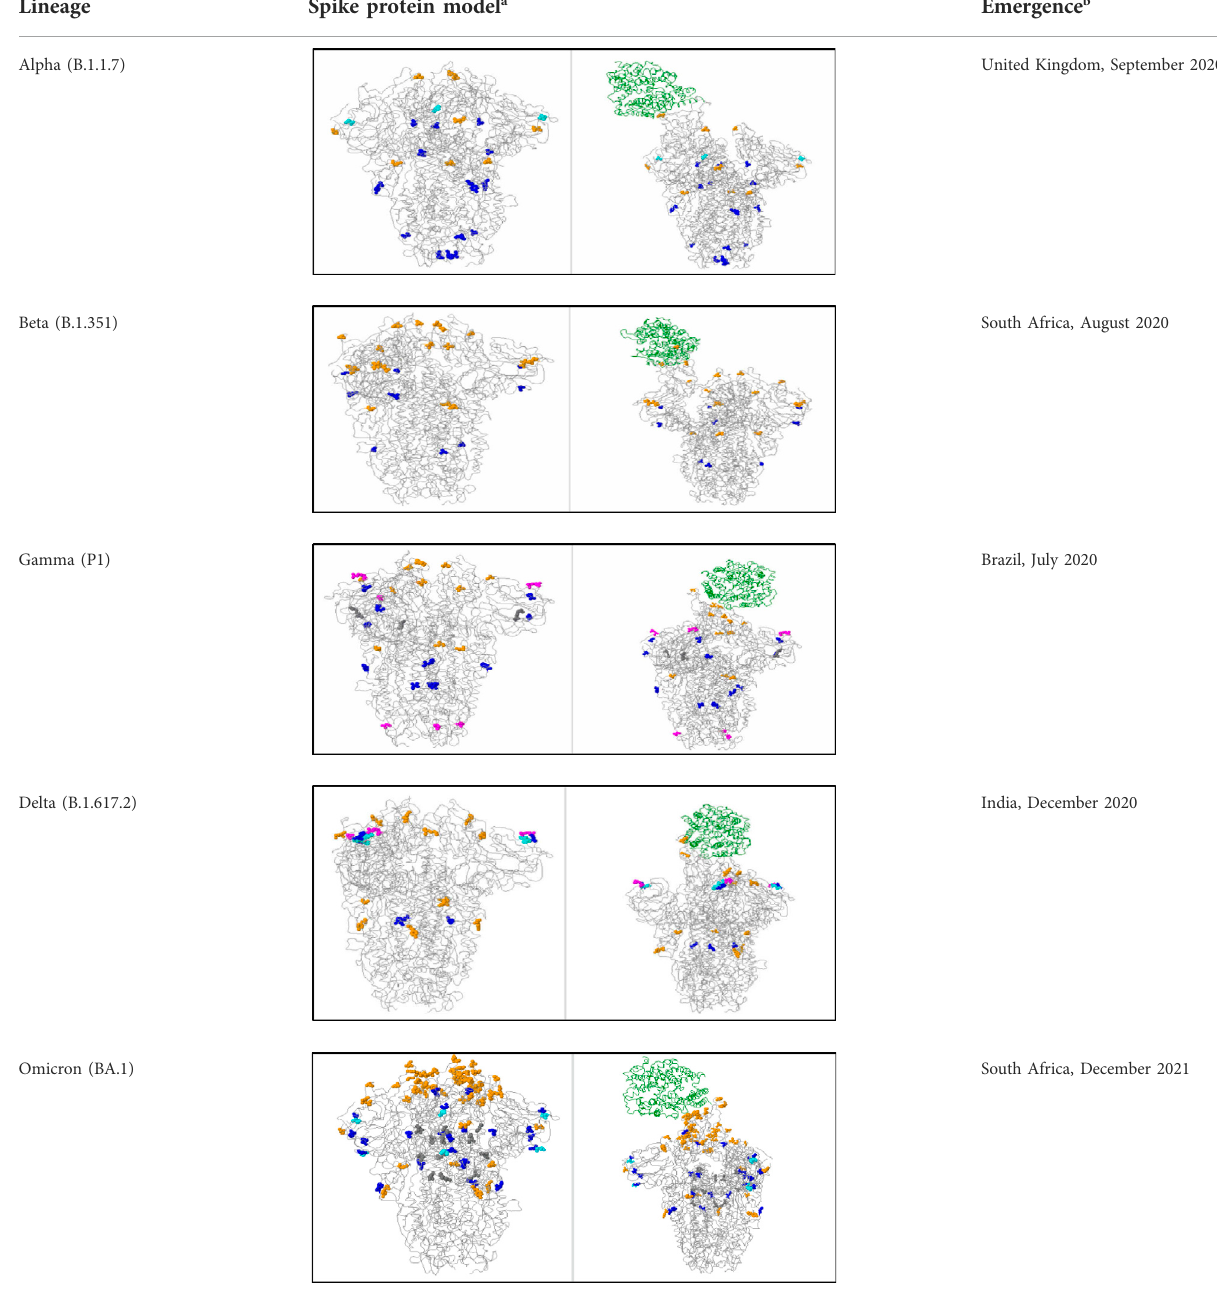
TABLE 2 Variants of concern of